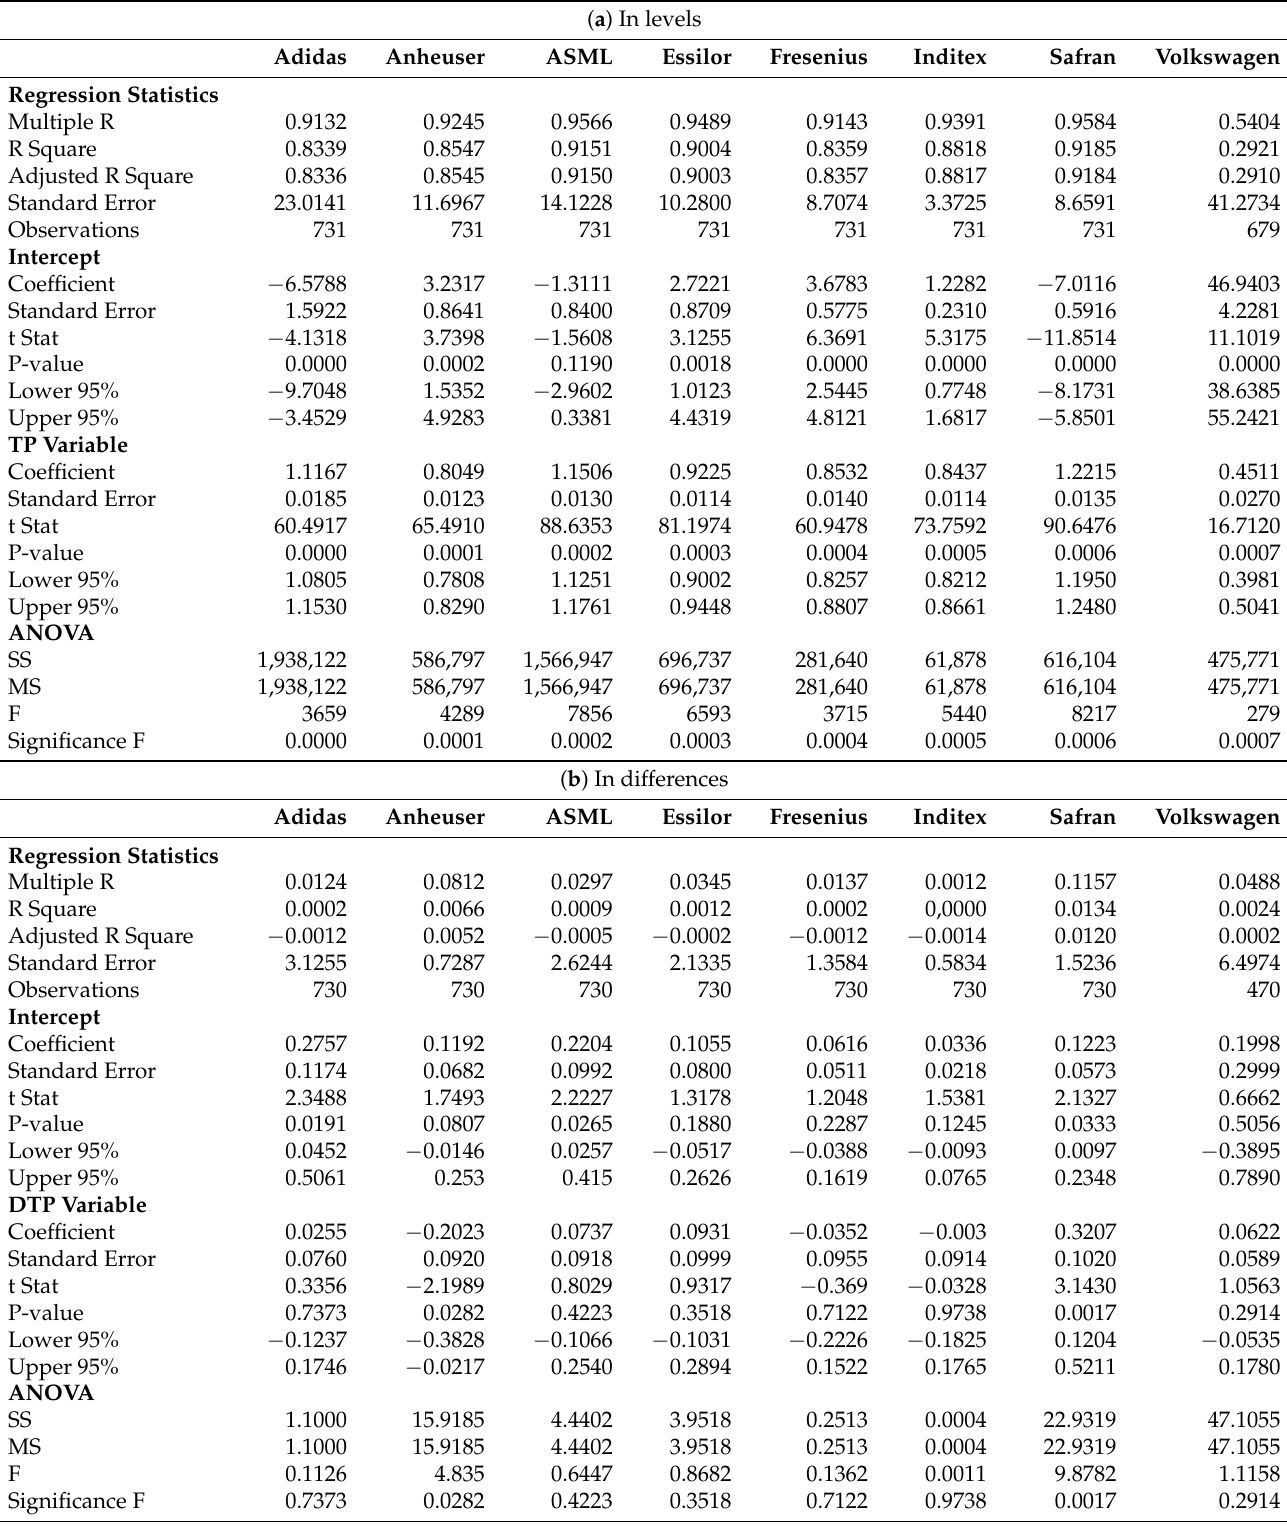
Table 5. Future prices vs. target prices: individual asset results. Individual regressions of future prices (FP) on target